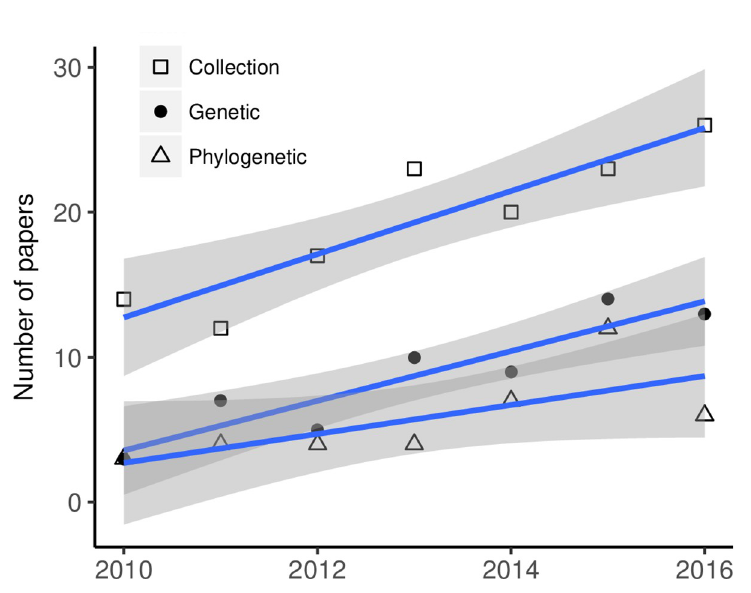
Fig 7. Data types linked to primary biodiversity data that increased over the period from 2010 through 2016. These include data needed for taxonomic/phylogenetic studies, namely those from natural history specimens, genetic data, and phylogenetic